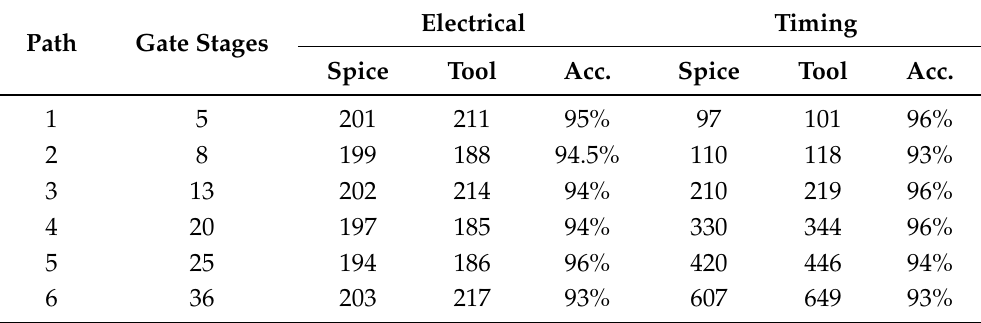
Table 3. Comparison of the proposed electrical and timing-masking models with SPICE on SET pulse propagation